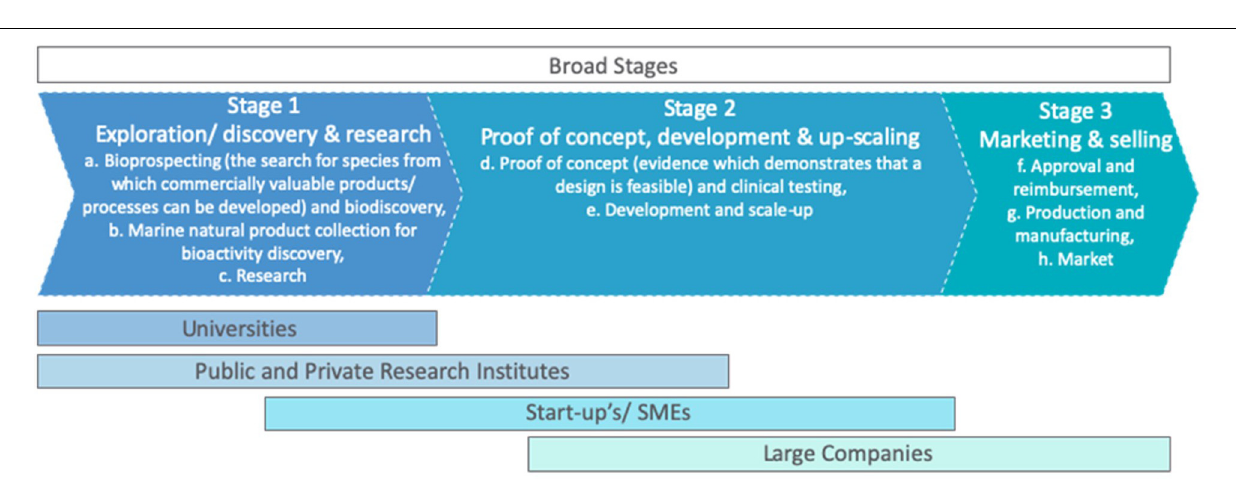
FIGURE 2 | The composition of stakeholders involved at three broad stages (1,2, and 3) within the marine bioresource value chain. Survey participants were asked to select which particular phase(s) within the marine bioresource value chain that their organization was involved with (phases a–g). Very few organizations were involved in only one phase (a–h) within the value chain. Therefore, for the sake of this study, phases have been grouped into three broad stages (1–3). Figure adapted from Ecorys (2014) and Calado et al.